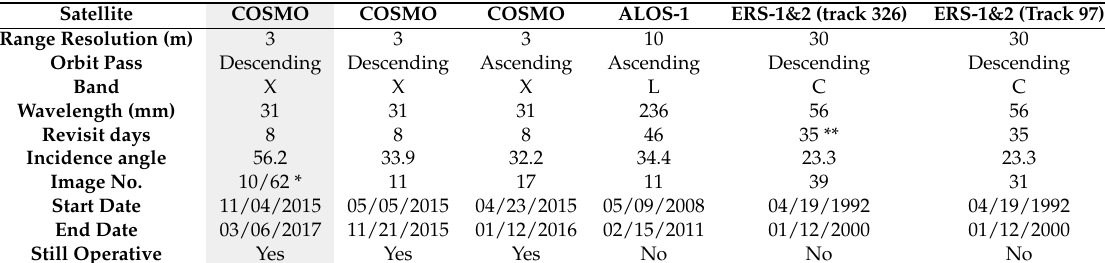
Figure 7. The AoI, DEM and available satellite data for this study. Table 1. Available satellites and tracks and their